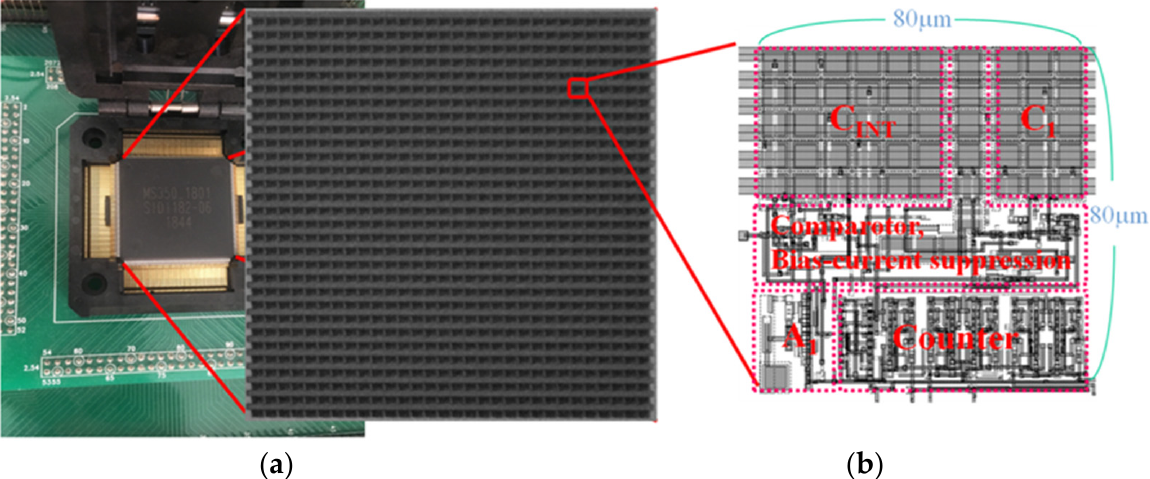
Figure 6. Measurement system: ( a ) operation board and fabricated chip; ( b ) mask layout of the proposed unit cell circuit for 2 × 2 bolometer array.